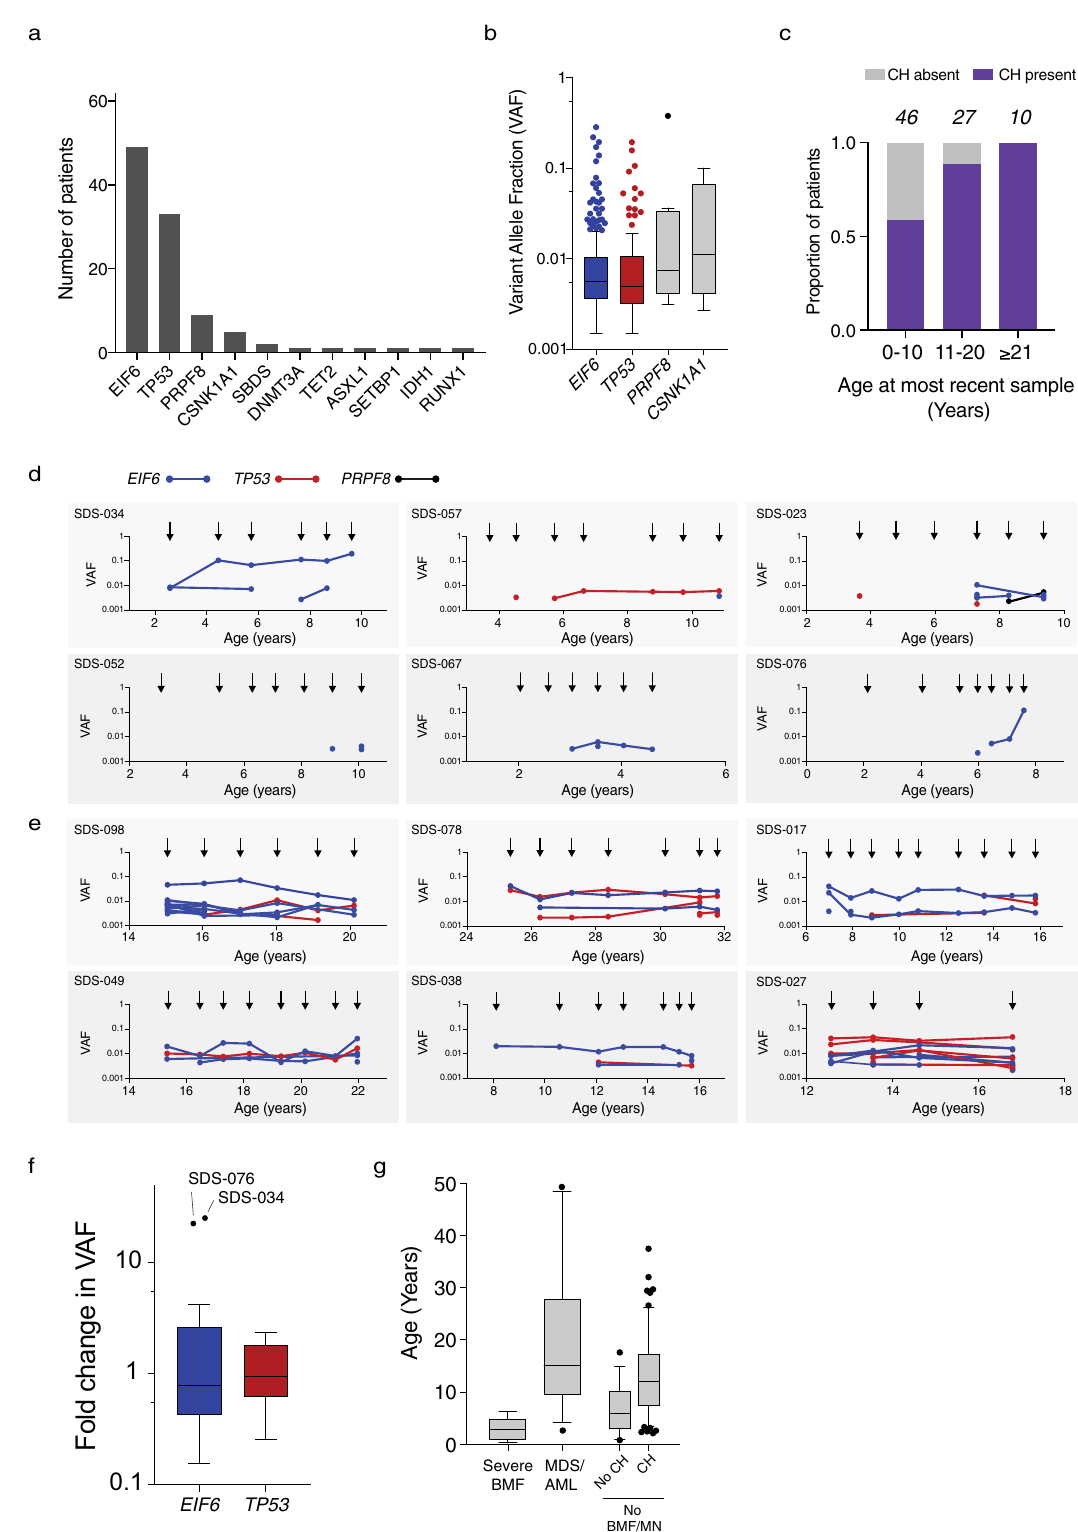
conclusion, our study elucidates biological mechanisms driving distinct pathways of CH in SDS and de fi nes a framework for rational surveillance. An improved ability to identify patients with high risk of developing leukemia has the potential to improve clinical outcomes by enabling preemptive intervention with cura- tive therapies, such as allogeneic transplantation.